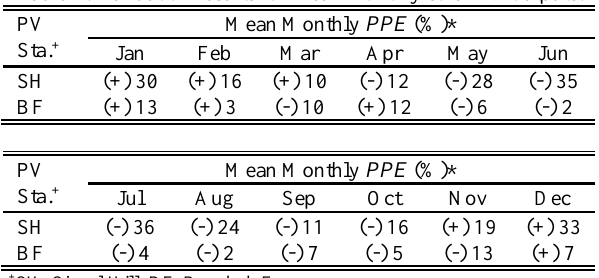
Table 2. Validation results for mean monthly solar PV outputs.